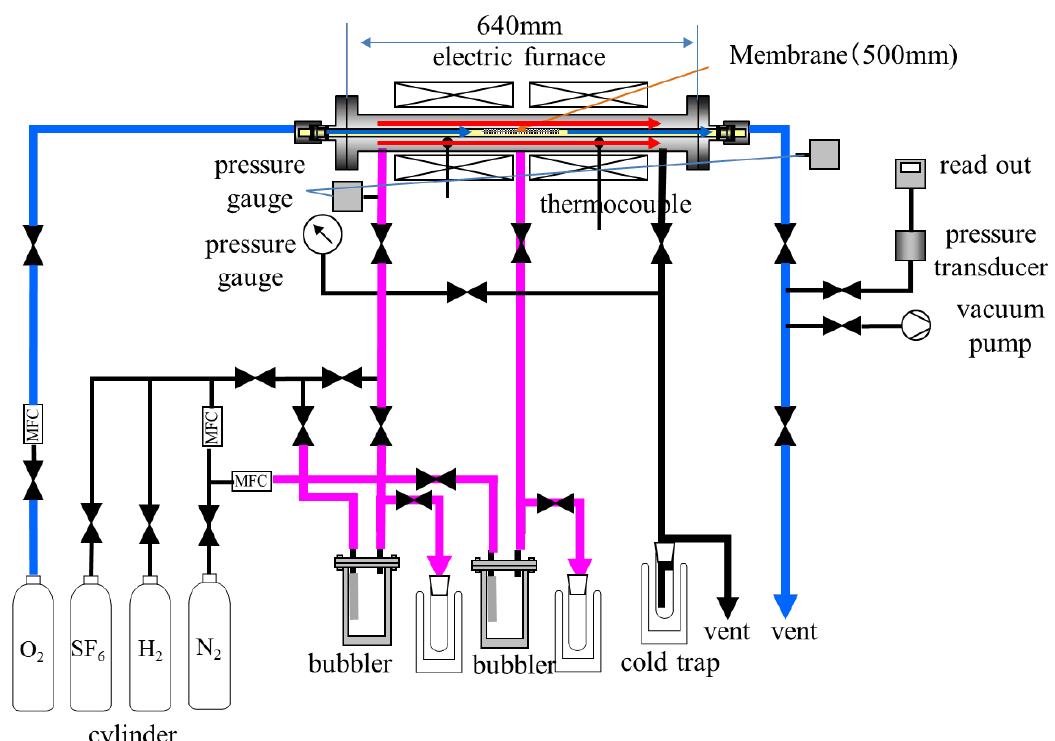
Figure 1. Schematic diagram of experimental apparatus for 500 mm–length silica membrane preparation and performance measurement.